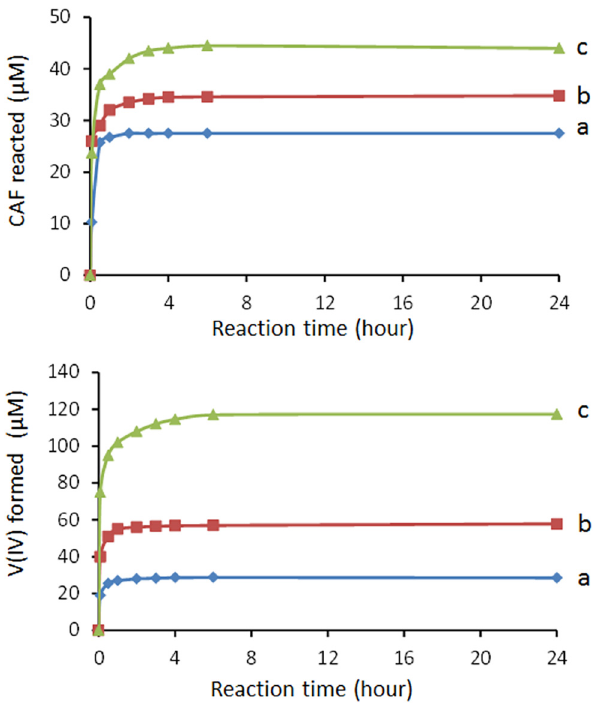
Fig 1. CAF reacted and V(IV) formed at pH 2.8 as a function of time and at different initial V(V) concentrations. Reaction conditions: CAF 60 μ M; V(V) 30 μ M (a), 60 μ M (b) and 120 μ M (c). Reaction volume 50